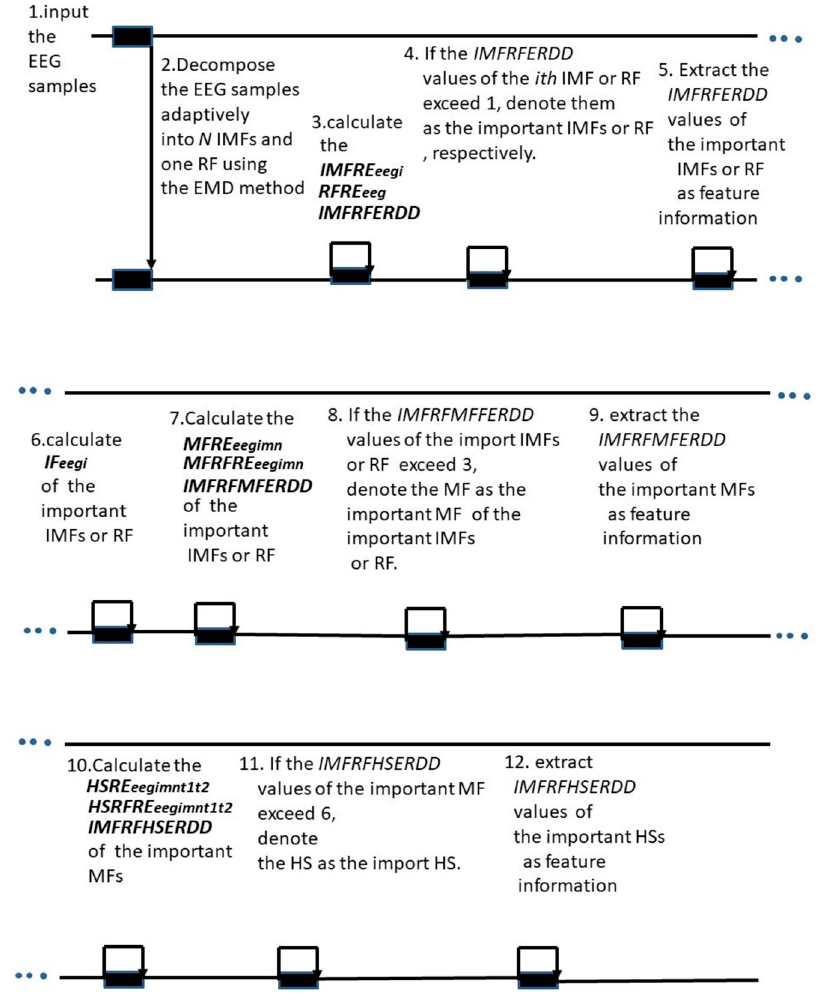
Figure 1. Schematic of the proposed feature extraction method.